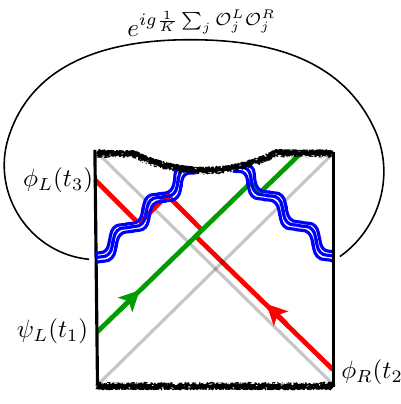
Figure 7 . Traversable wormhole setup: the ‘signal’ φ collides with the ‘perturbation’ ψ and subsequently exits the wormhole due to a negative energy shock created by the left-right coupling h i P K exp . This way, we can extract information about the collision from behind ig 1 O L O R j j j =1 K the